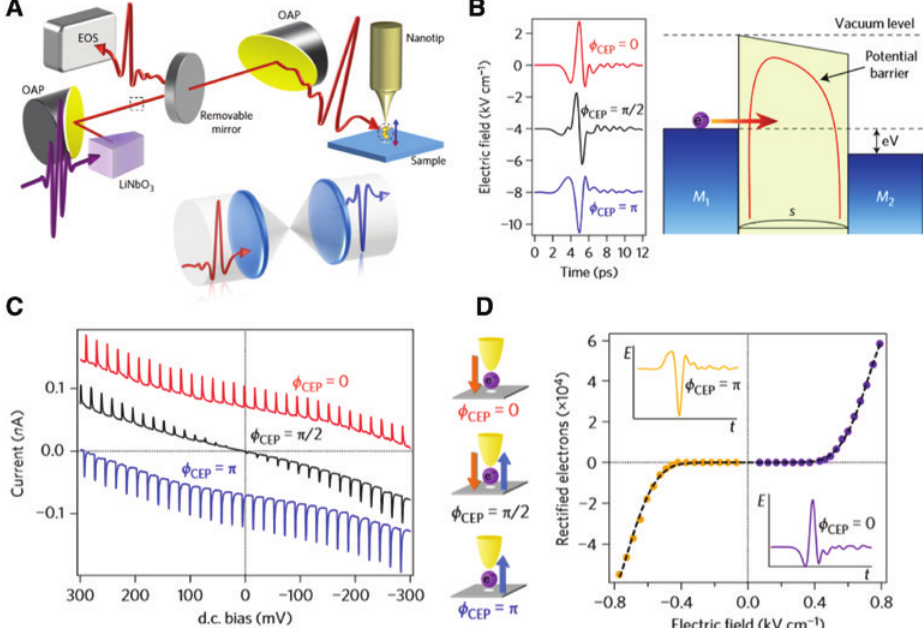
Figure 4: THz-STM system based on CEP–controlled terahertz fields. (A) Schematic of THz-STM setup. The incident terahertz pulse is focused onto the metal nanotip and coupled via antenna-like plasmonic effect. The CEP of single-cycle terahertz pulse is controlled by a pair of cylindrical or spherical lenses. (B) Terahertz electric fields in time domain with different CEP (0, π /2, and π ), which show half- (red and blue lines) and single-cycle (black line) terahertz electric fields (left). The CEP-controlled terahertz electric field modifies potential barrier between metal tip and sample (right). (C) The tunnel current as a function of DC bias voltage in the tip–sample junction for different CEP terahertz electric fields. (D) Schematic of electron motion between the metal nanotip to sample for different CEP (left) and terahertz field–induced rectified electrons as a function of peak field of terahertz pulse (right). The CEP-controlled terahertz field leads to the unidirectional coherent motion of electrons. The figures are reproduced from Reference